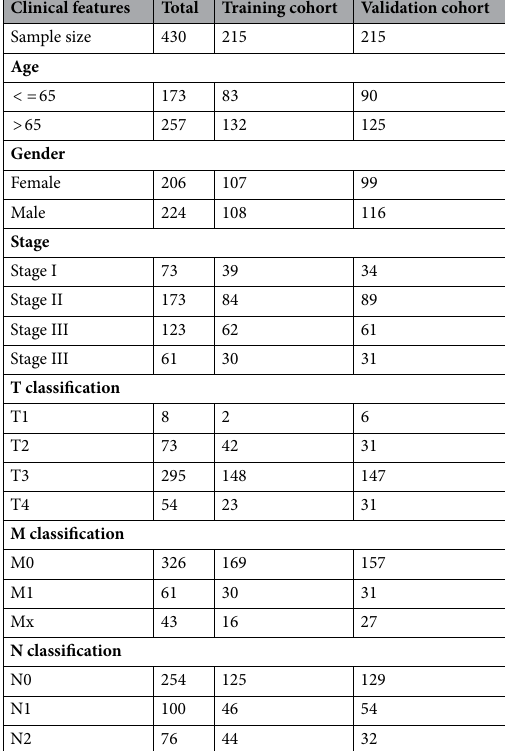
Fig. 7F). The risk score was found inversely proportional to the stromal and immune score of the tumor micro- environment (immune score, cor = − 0.15, P < 0.001; stromal score, cor = − 0.18, P < 0.001; Fig. 7G). Interestingly, decreases in stromal and immune scores were associated with poor prognosis in COAD patients (Fig. 7H–I). The mRNA expression of seven lncRNAs in COAD cell lines. We evaluated the mRNA level of seven lncRNAs (AC027307.2, AC073611.1, AC156455.1, AL161729.4, LINC01063, MIR210HG and PCAT6) in five COAD cell lines and normal colon mucosal epithelial cell line (Fig. 8). The result revealed that AC027307.2 has a lower expression level in HCT116 and DLD-1 cell lines than CCD-18Co (Fig. 8A). The mRNA level of AC073611.1, MIR210HG, AL161729.4 and LINC01063 has no statistically significant difference between cancer and normal cell lines (Fig. 8B–E). AC156455.1 mRNA level is significantly down-regulated in SW480, LS174T and HT29 cell lines (Fig. 8F). A higher mRNA level of PCAT6 is observed in SW480, LS174T and HCT116 cell